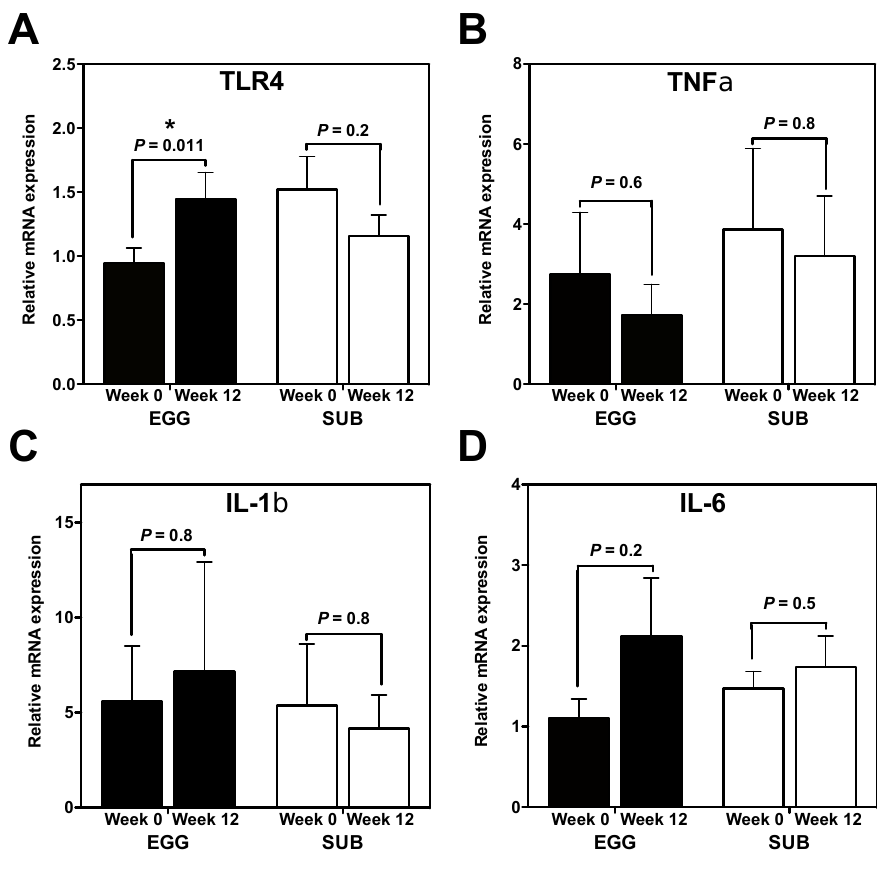
Figure 1. Whole egg intake during moderate carbohydrate restriction increases PBMC mRNA expression of TLR4. PBMC mRNA expression of pro-inflammatory genes at baseline and week 12 of a moderate carbohydrate-restricted diet plus whole egg ( n = 18) or egg substitute ( n = 15) intake. qRT-PCR was used to measure PBMC mRNA expression of ( A ) TLR4; ( B ) TNFα; ( C ) IL-1β; and ( D ) IL-6. All data were normalized to 18S rRNA expression and expressed as mean ± SEM. * P = 0.011, paired t test comparing PBMC TLR4 mRNA expression between baseline and week 12 in the EGG